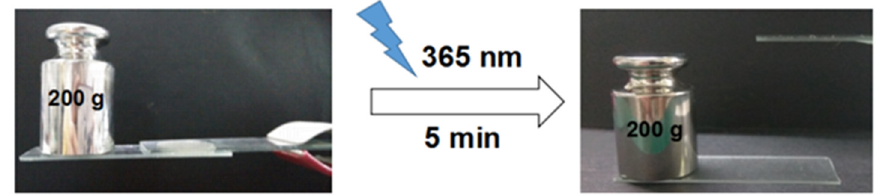
Figure 8. The bonding performance test.